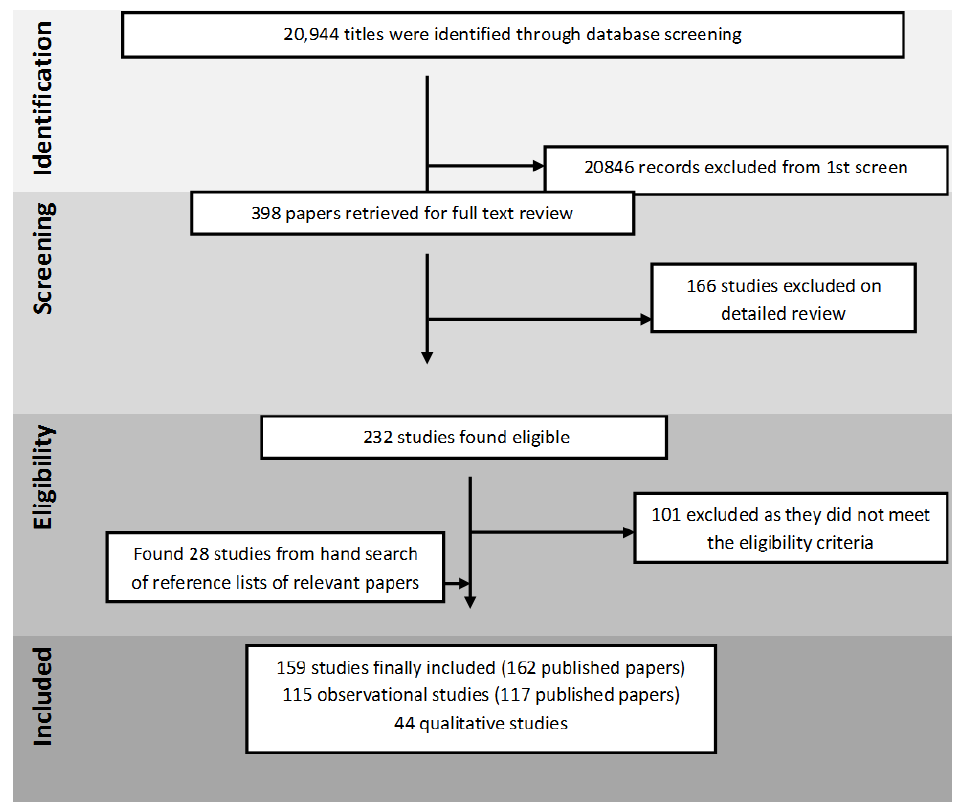
Figure 1. Search flow